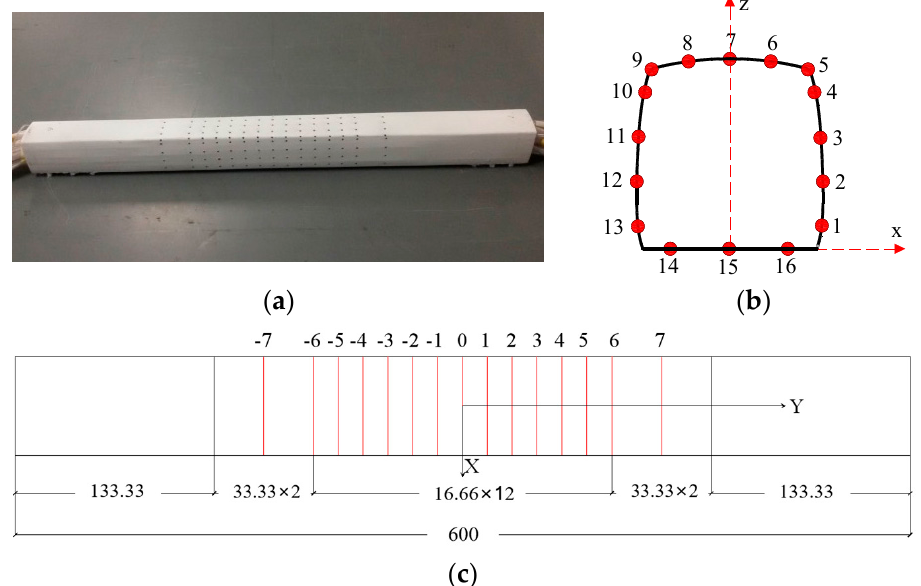
Figure 3. Physical train model and pressure tap installation. ( a ) Actual rigid model of the train car; ( b ) Pressure tap distribution over one section. ( c ) Arrangement of pressure tap sections along model axis (unit: mm).